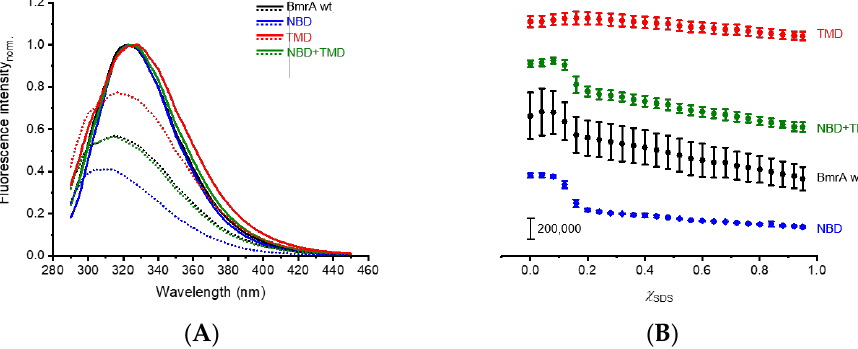
Figure 3. SDS-induced unfolding of full-length BmrA wt and the isolated domains. ( A ) Normalized emission spectra of BmrA wt full-length (black), NBD (blue), TMD (red), and NBD + TMD (green). The mean emission spectra of three independent purifications are shown for the native proteins/domains ( χ SDS = 0, lines) and the proteins/domains exposed to the highest SDS mole fraction ( χ SDS = 0.95, dotted lines) (without SD). ( B ) The fluorescence intensities of full-length BmrA wt (black), NBD (blue), TMD (red), and NBD + TMD (green) at increasing χ SDS were determined at a fixed wavelength (BmrA wt: 322 nm; NBD: 324 nm; TMD: 328 nm; NBD + TMD: 323 nm). Data points represent the means of three independent purifications (±SD). The curves are shifted vertically for clarity.